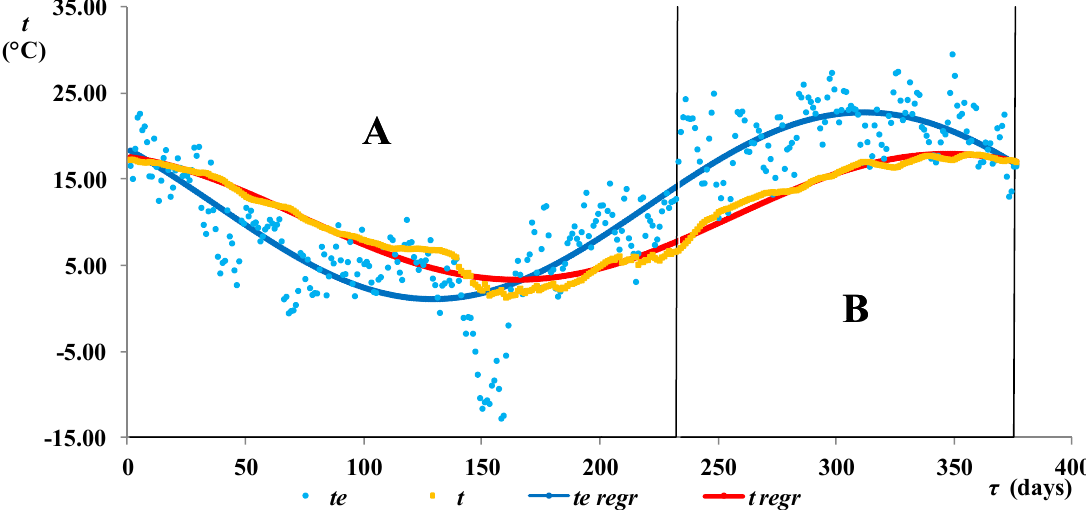
Figure 2. Temperatures of a soil containing a slinky heat exchanger from 7 September 2011 to 16 September